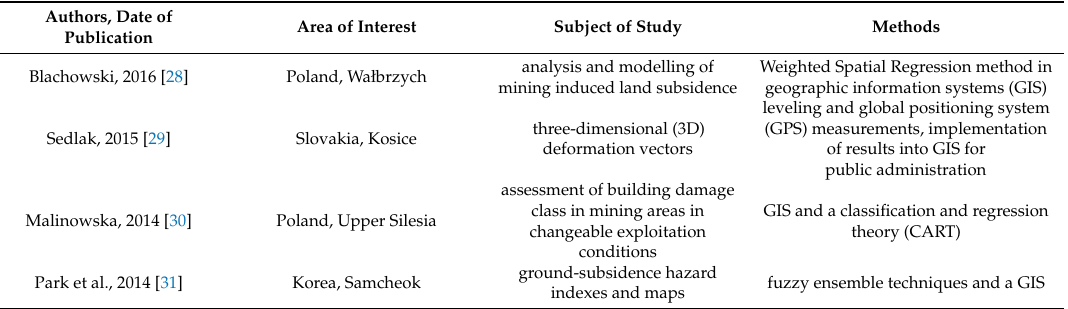
Table 2. Studies of terrain deformations caused by mining utilizing geographic information